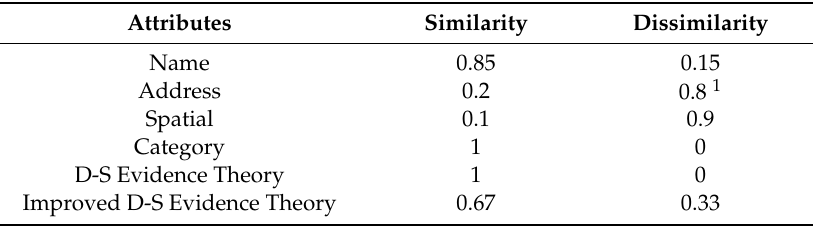
Table 3. One trust